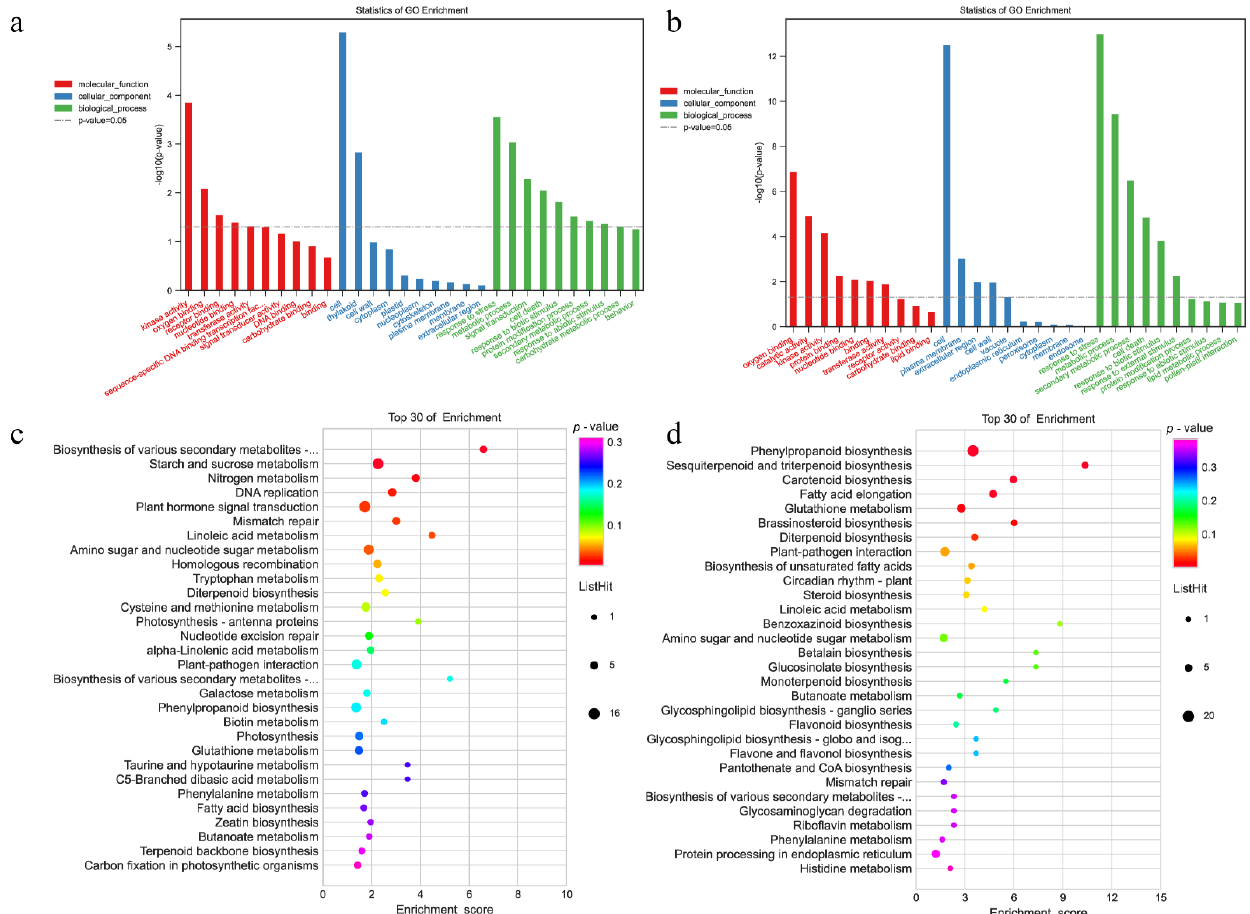
Figure 5. Gene ontology (GO) and Kyoto Encyclopedia of Genes and Genomes (KEGG) enrichment analysis: ( a ) GO analysis of the AZ-specific DEGs of W517. ( b ) GO analysis of the AZ-specific DEGs of DZ129. ( c ) KEGG analysis of the AZ-specific DEGs of W517. ( d ) KEGG analysis of the AZ-specific DEGs of DZ129.